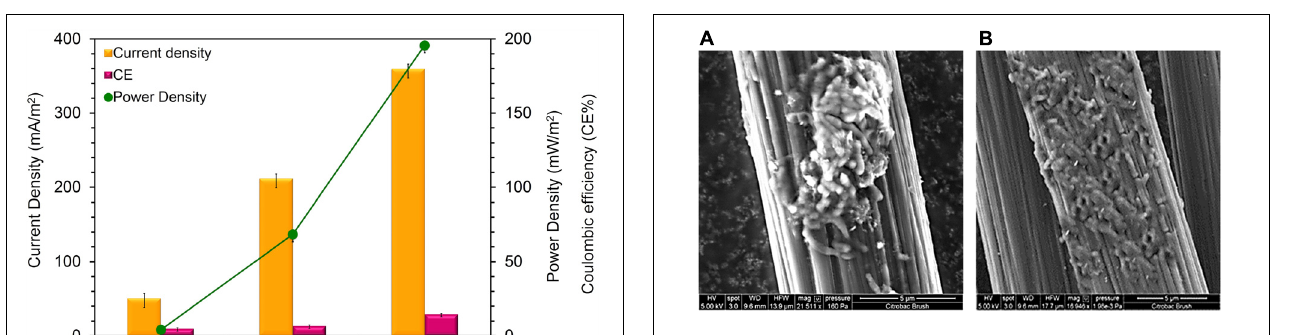
FIGURE 8 | Electrode micrographs: (A) New, uninoculated control anode (B) SEM micrograph of an electrode surface following growth of Citrobacter